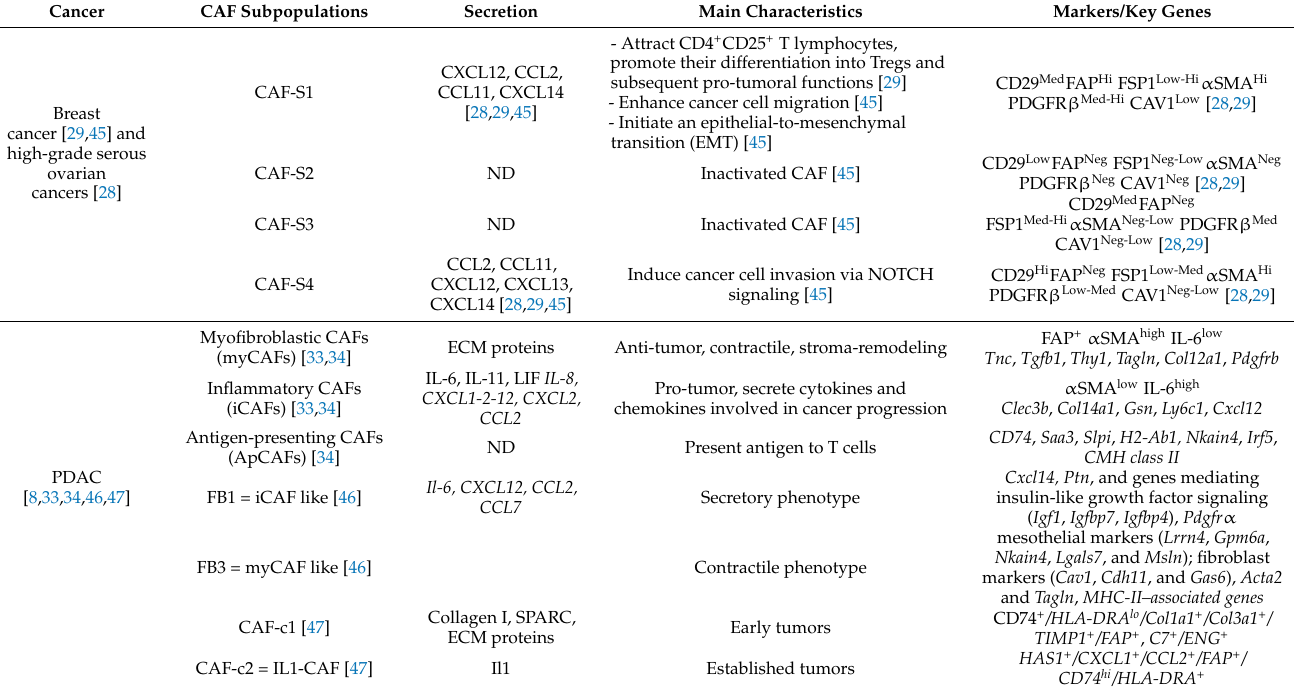
Table 1. CAF subgrouping in breast, ovarian, pancreatic, lung and colorectal cancers associated with identified secretions, main tumoral characteristics and markers. Italic refers to genes. Abbreviations: Acta2: Actin Alpha 2, Smooth Muscle; C7: Complement C7; CAV: Caveolin; CCL: C-C Motif Chemokine Ligand; CD74: Cluster of Differentiation 74;